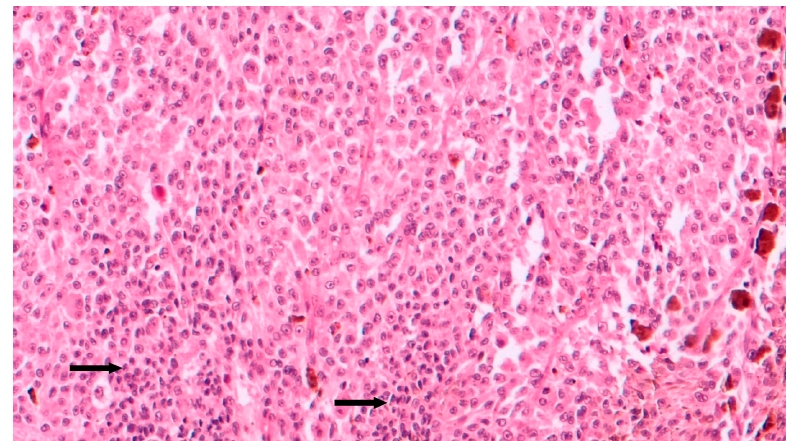
Figure 4. High magnification showing mixed cell type choroidal melanoma, composed of both epithelioid and spindle cells (hematoxylin and eosin; original magnification 200×).